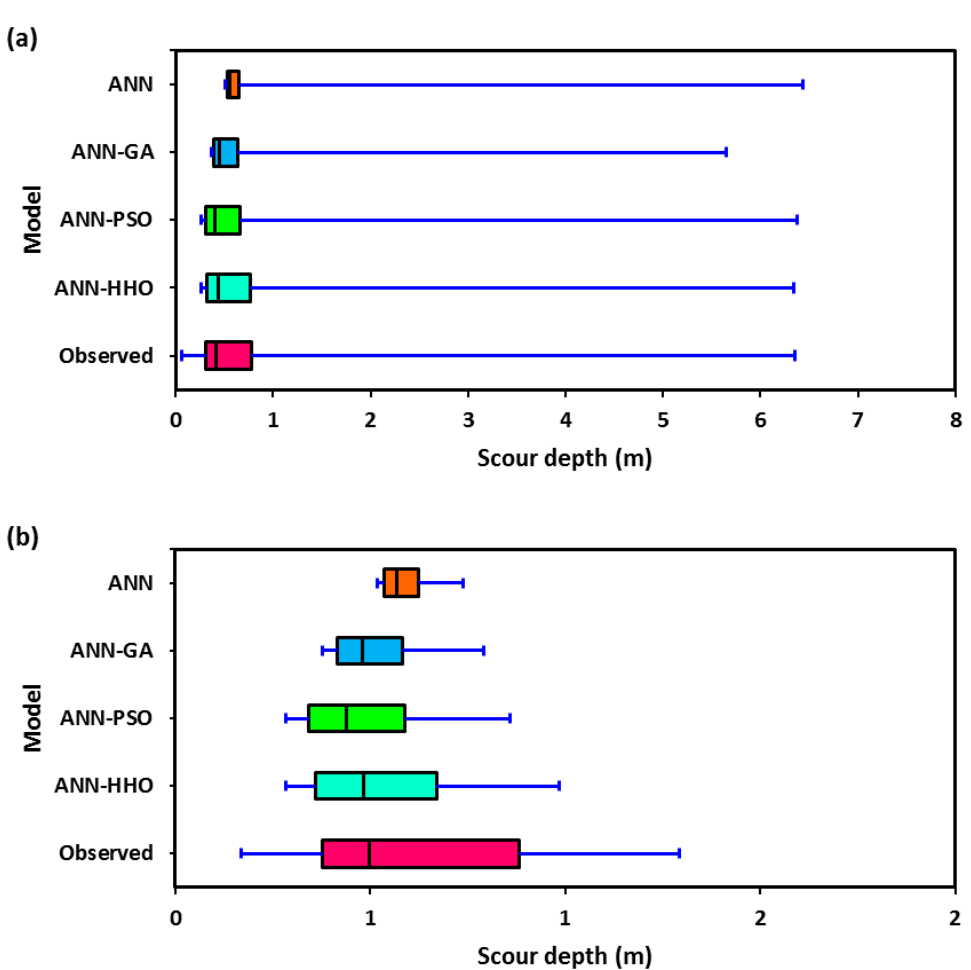
Figure 6. Box plots of observed and predicted scour depth by ANN-HHO, ANN-PSO, ANN-GA, ANN models during ( a ) training, and ( b ) testing periods.